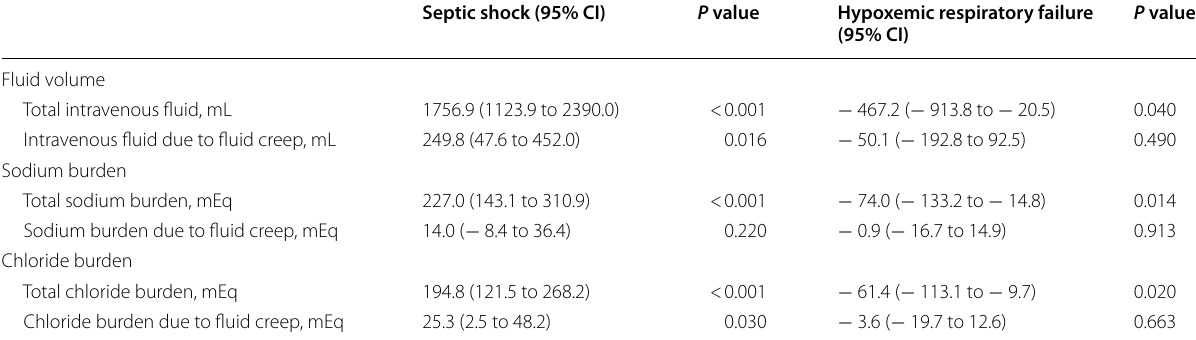
Table 3 Estimates of the effects of septic shock and hypoxemic respiratory failure to a burden of fluid, sodium, and chloride within